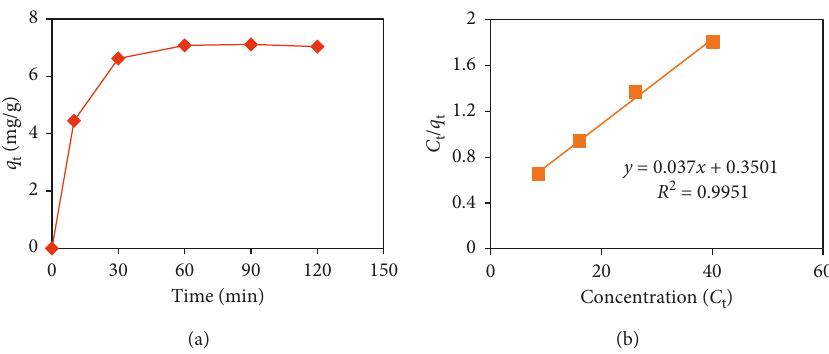
Figure 4: Diazinon adsorption capacities by the synthesized Fe-TiO